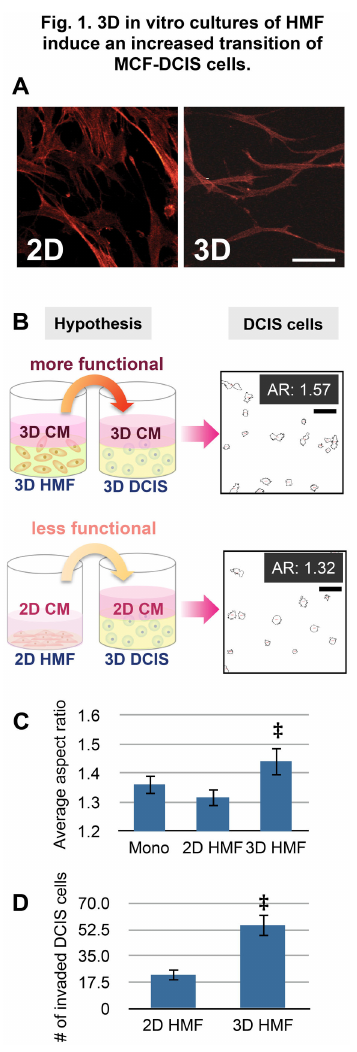
Figure 1. 3D in vitro culture of HMF induces an increased transition of MCF-DCIS cells. (A) Different morphologies of HMFs in 2D vs. 3D conditions. These images clearly show that HMFs in 3D have more fiber-like structures. The scale bar represents 60 µm. (B) Conceptual illustration of the difference of HMF behaviors in 2D and 3D. The conditioned medium collected from 3D culture of HMF (3D CM) stimulates invasive transition more than the conditioned medium collected from 2D culture of HMF (2D CM), and stimulates more invasive transition of MCF-DCIS cells in 3D. Outlines of MCF-DCIS clusters cultured in 3D mixed matrix with 3D CM and 2D CM. The clusters cultured with 3D CM produced more elongated clusters with aspect ratio (AR) 1.57. Scale bar is 100 μm. (C) Bar graph showing average aspect ratio of MCF-DCIS clusters cultured with control (serum free medium, mono), 2D HMF (co- cultured with HMFs in 2D), and 3D HMF (co-cultured with HMFs in 3D). ‡ represents p value of 0.048. (D) Bar graph showing data obtained from transwell invasion assays with conditioned media from 2D culture of HMF (2D HMF) and 3D culture of HMF (3D HMF). ‡ represents p value of 0.022.